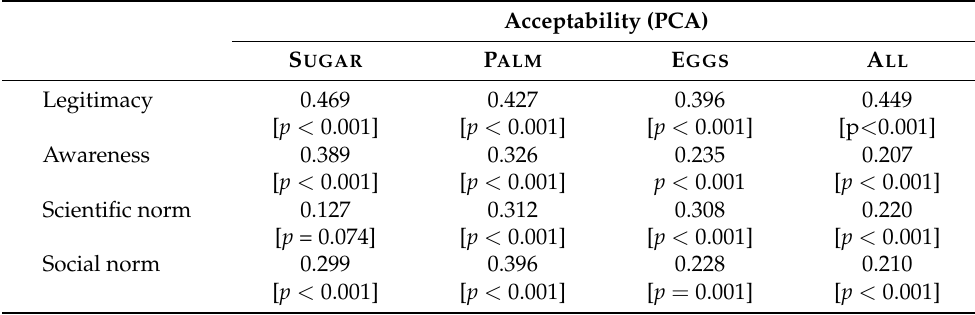
Table A1. Correlation between topic-level factors and average acceptability.